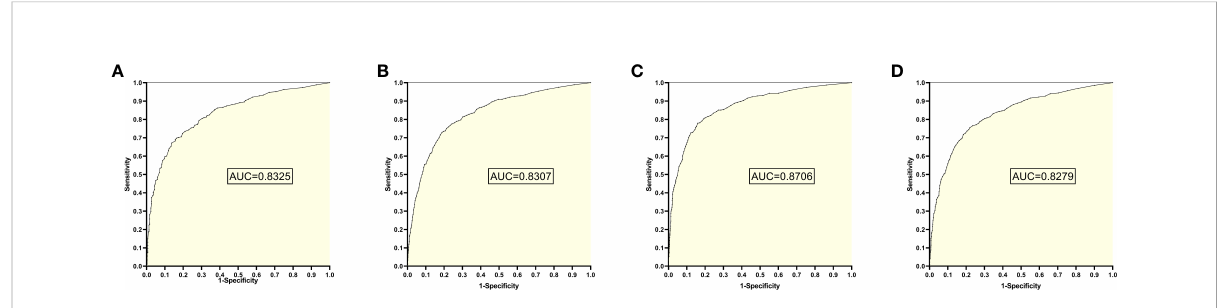
FIGURE 2 ROC curves and AUC values obtained from training set 1 model testing each test set: (A) results from test set 1; (B) results from test set 2; (C) results from test set 3; (D) results from test set